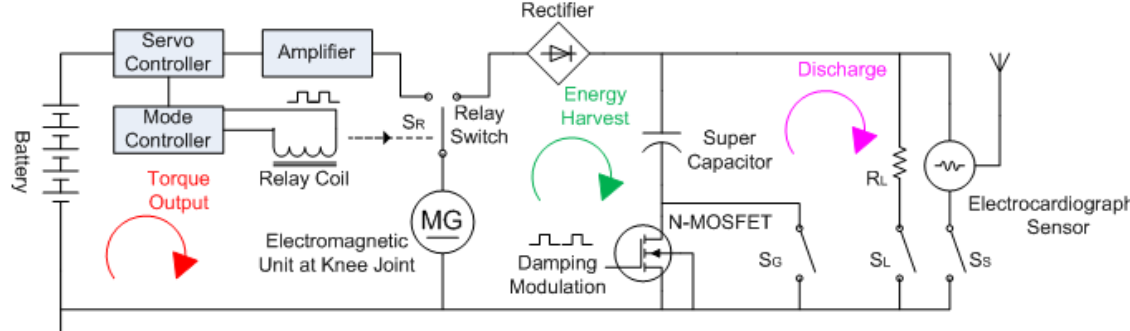
Figure 10. Electric circuit schematic with both the torque output cycle, energy harvesting cycle, and discharge cycle for the Bowden cable-actuated knee exoskeleton.